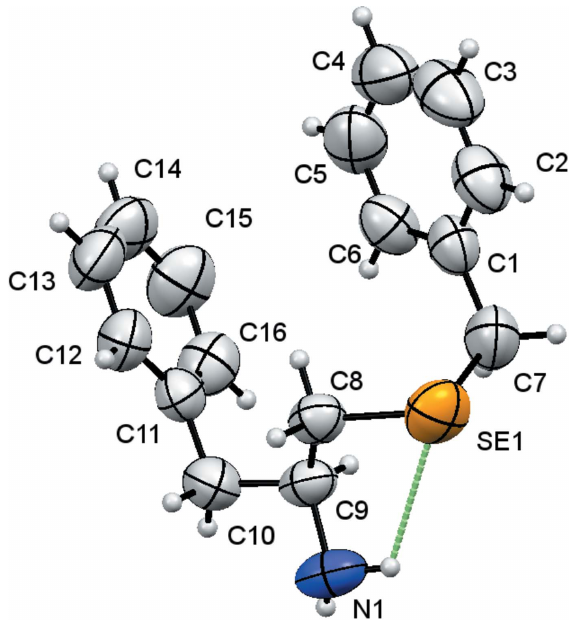
Figure 1 The molecular structure of the title compound with displacement ellipsoids drawn at the 50% probability level.